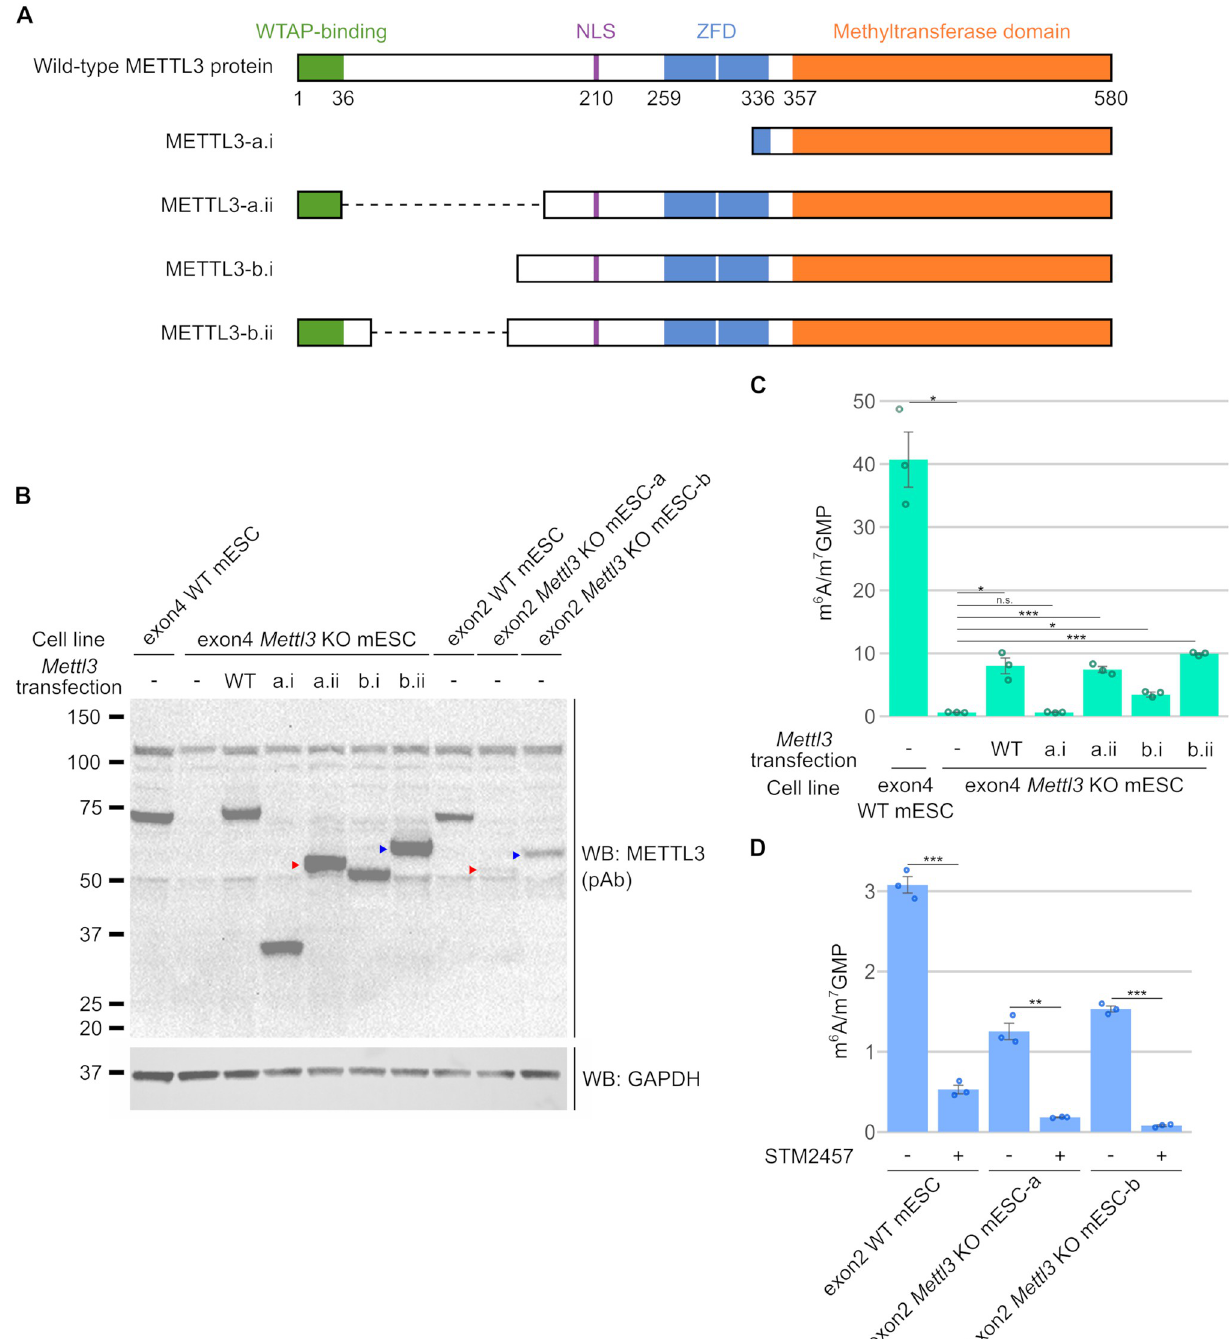
Fig 2. Shortened isoforms of METTL3 catalyze m 6 A formation in Mettl3 KO mESCs. ( A ) The predicted domain structure of proteins encoded by the altered METTL3 ORFs expressed in exon2 Mettl3 KO mESCs suggests they may be functional. The domains that are known to be necessary for m 6 A formation by METTL3 include the WTAP-binding domain [39], ZFD [19,36], and methyltransferase domain [19,20].To determine if the METTL3 ORFs from exon2 Mettl3 KO mESCs encode functional METTL3 proteins, we predicted the domain structure of the METTL3 protein isoforms from their ORFs. While all the predicted proteins have the methyltransferase domain, only METTL3-a.ii and METTL3-b.ii have all the known critical domains for m 6 A-writing. ( B ) WB of transfected FLAG-tagged METTL3 isoform ORFs. To determine if the METTL3 ORFs we found in the knockout cells can synthesize m 6 A, we expressed the METTL3 ORFs in exon4 Mettl3 KO mESCs that exhibit no METTL3 protein and essentially no baseline m 6 A signal. After 48 h, the alternatively spliced METTL3 proteins can be detected by immunoblotting with an anti-METTL3 antibody. FLAG-METTL3-a.ii (50 kDa, red arrowhead) and FLAG-METTL3-b.ii (55 kDa, blue arrowhead) have similar sizes to the anti-METTL3-antibody-reactive protein seen in exon2 Mettl3 KO mESC-a (red arrowhead) and exon2 Mettl3 KO mESC-b (blue arrowhead), respectively. 30 μ g per lane. ( C ) Isoforms of METTL3 proteins can write